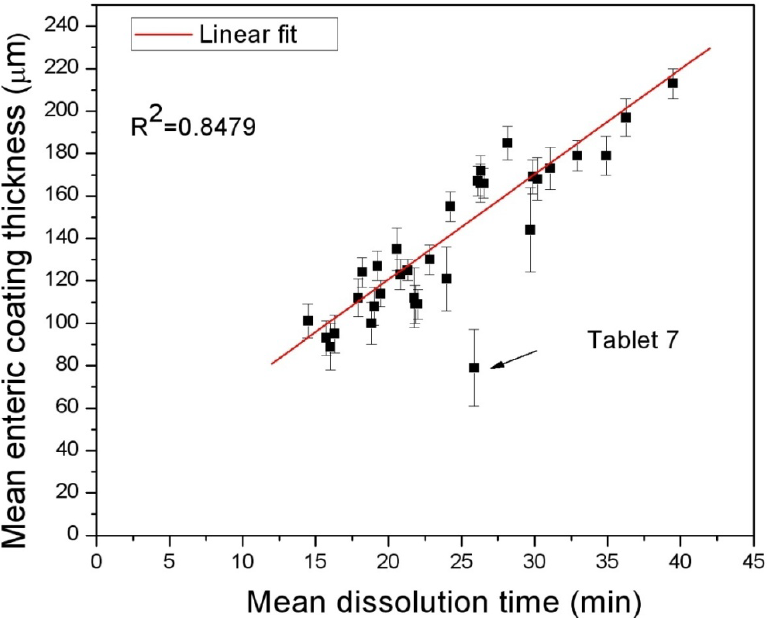
Figure 3. The mean dissolution time in minutes against the thickness of the enteric coating as measured with terahertz pulsed imaging. The error bars are the variation in the enteric coating thickness as measured across the whole tablet.